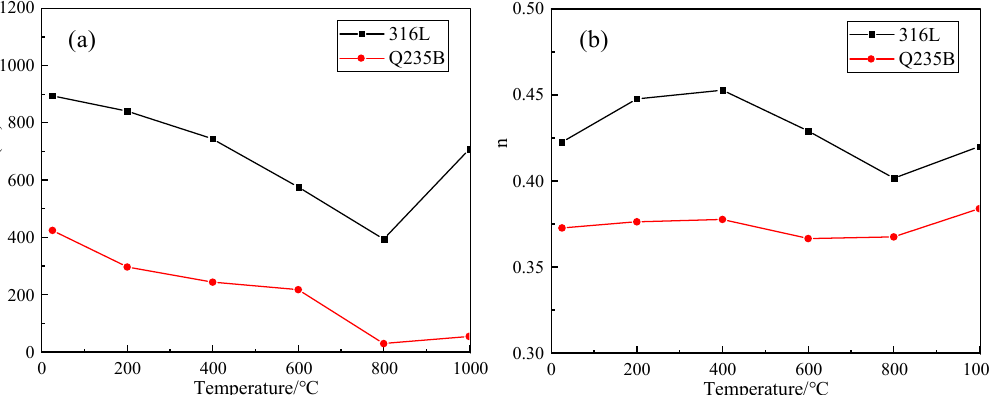
Figure 5. Fitting values of B and n parameters of 316L and Q235B. ( a ) Change of B parameter with